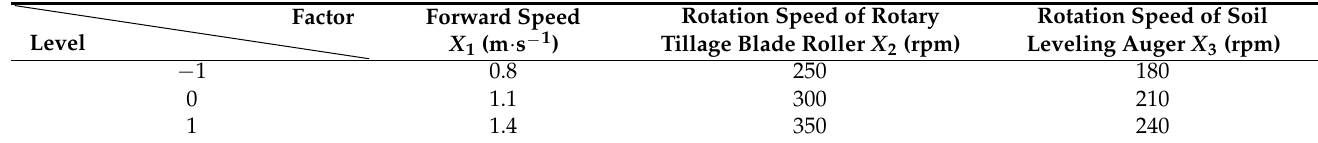
Table 2. Three factors and three levels of parameter optimization test for seedbed preparation machine.